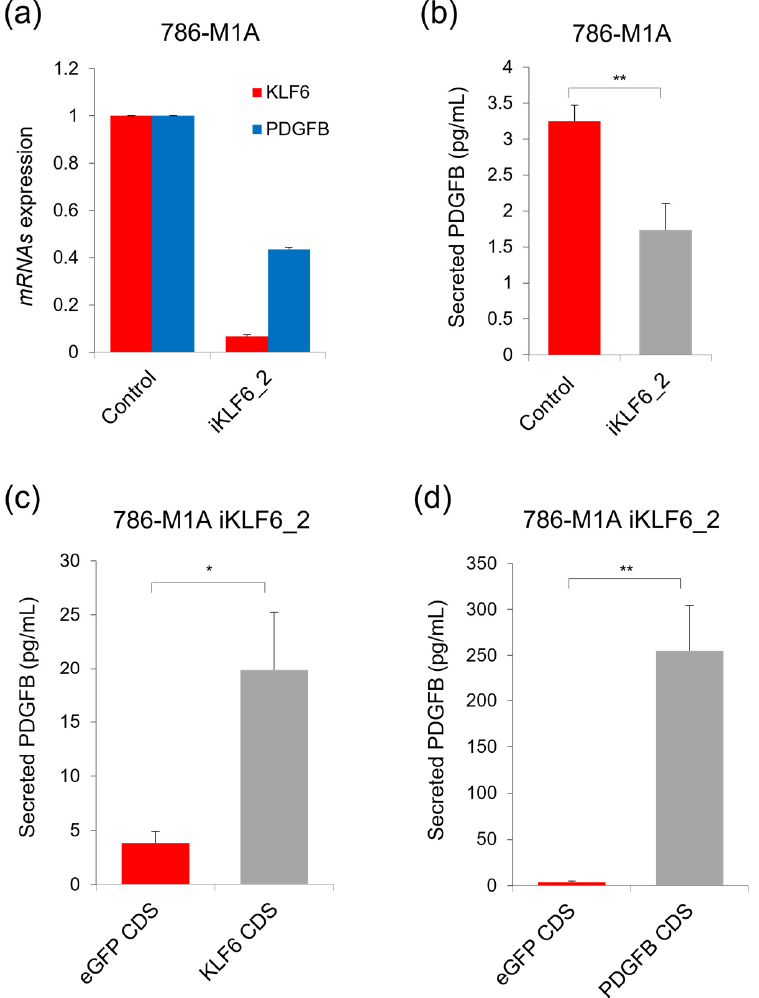
Figure 3. PDGFB secretion level in 786-M1A cells correlate with the expression of its upstream regulator KLF6. ( a ) The expression of KLF6 and PDGFB in the KLF6-repressed 786-M1A cells. Average of three independent experiments. Error bars represent SD. ( b ) The level of secreted PDGFB of the KLF6-repressed 786-M1A cells. ( c ) The secreted PDGFB level upon the reintroduction of exogenous KLF6 CDS into the KLF6-repressed 786-M1A cells. ( d ) PDGFB secretion level in the KLF6-repressed 786-M1A cells reintroduced with exogenous PDGFB CDS. ( b – d ) Average of three independent experiments. Error bars represent SD. p -value by two-tailed t -test. ** p < 0.005, * p < 0.05. We further validated the fi ndings in Figure 3 by measuring the level of extracellular PDGFB in an additional set of KLF6-modulated ccRCC cells, which were the UOK101 cells. CRISPRi-mediated KLF6 repression in UOK101 cells reduced PDGFB expression, whereby the reintroduction of exogenous KLF6 CDS in these cells resulted in PDGFB up- regulation (Figure 4a,b and Supplementary Figure S2a). We found that the PDGFB secre- tion level in these UOK101 cells also positively correlated with the expression of